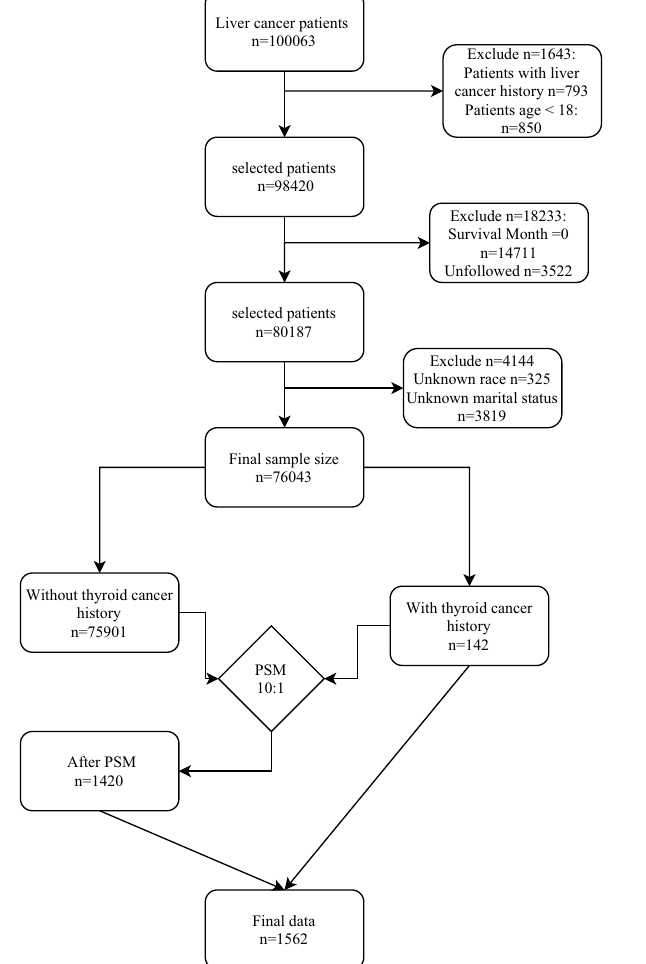
Figure 1. Flow chart of the study